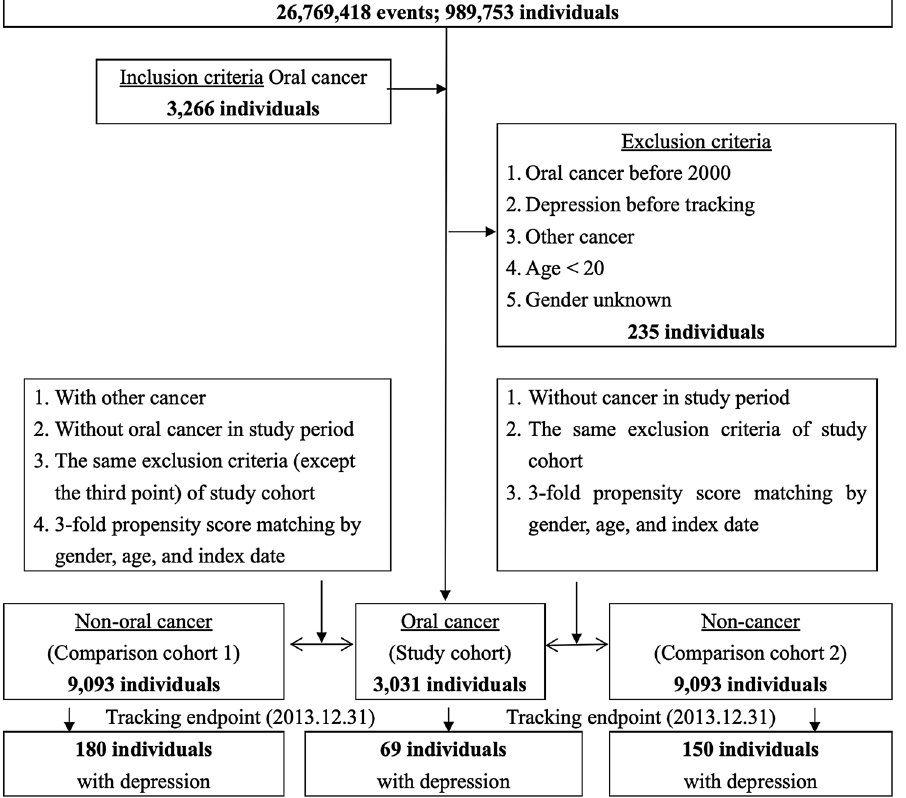
Figure 1. The flowchart of study sample selection from National Health Insurance Research Database in